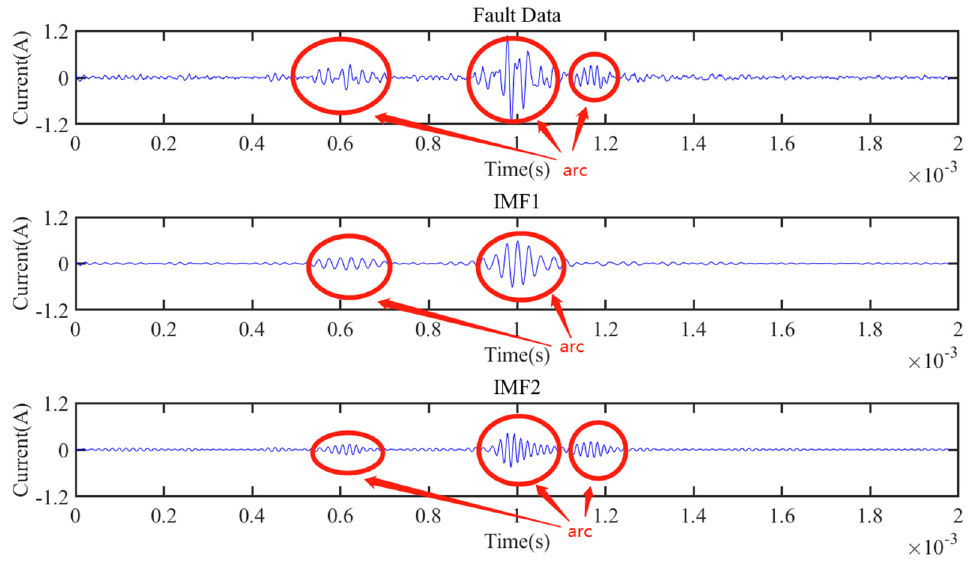
Figure 15. The observed arc part of original data, IMF1 and IMF2.